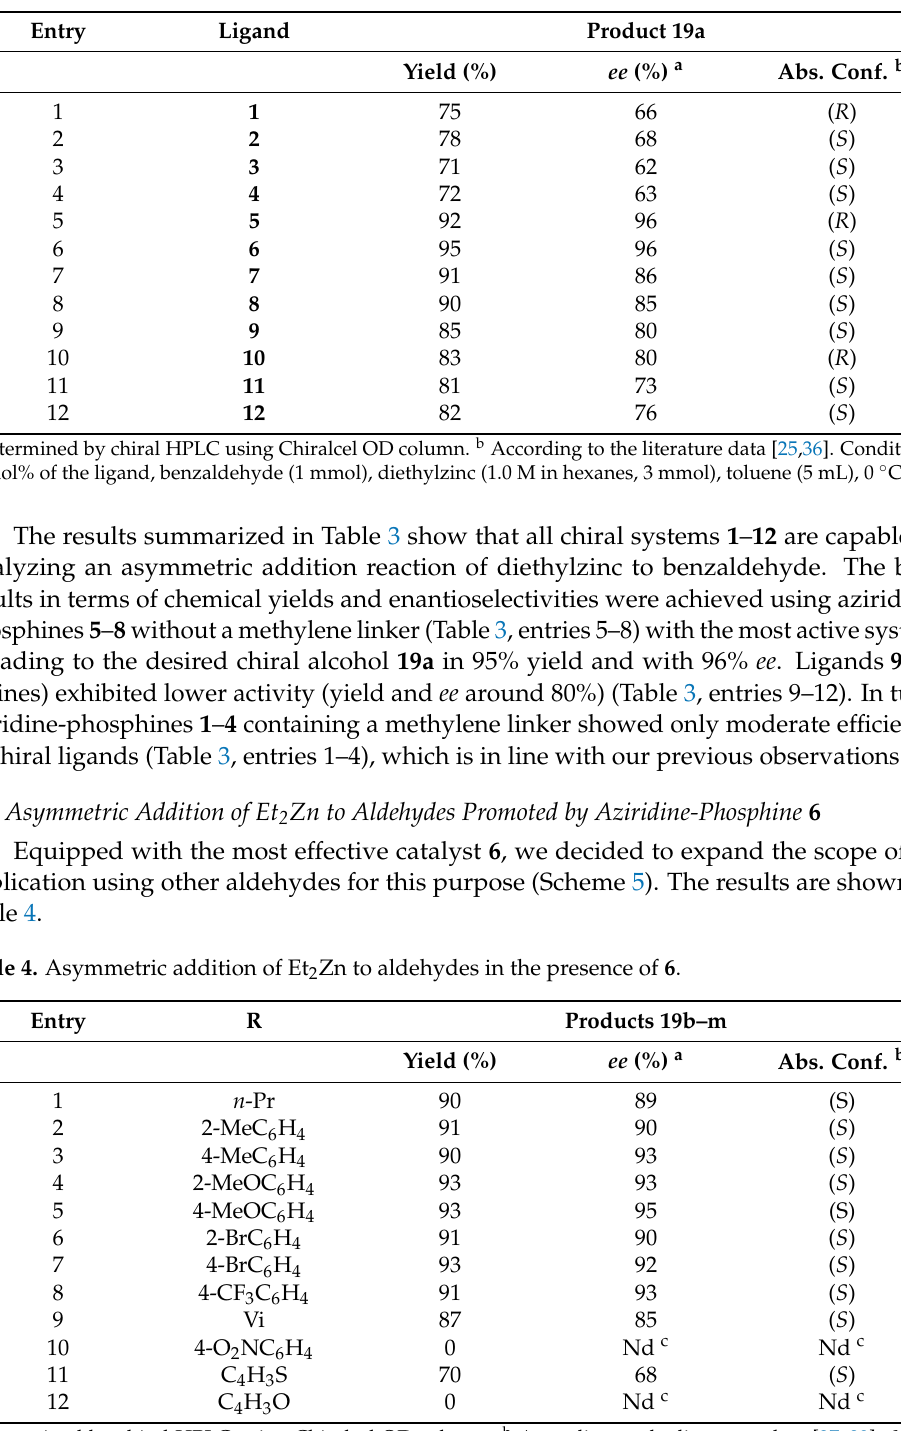
Table 3. Asymmetric addition of Et 2 Zn to benzaldehyde in the presence of 1 – 12 .